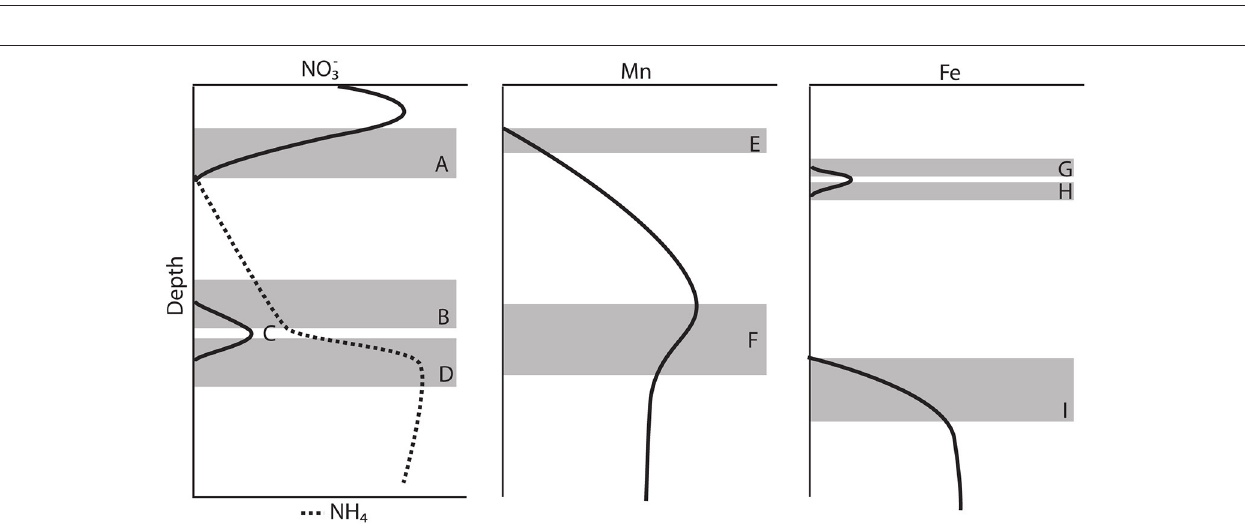
FIGURE 4 | Schematic model of the major features observed in most of the gravity core pore water profiles. (A) Consumption zone of the primary NO − 3 peak. (B) Upper zone of the secondary NO − 3 peak. (C) Secondary NO − 3 peak, change in NH + 4 gradient. (D) Lower zone of the secondary NO − 3 peak. (E) Mn + 2 appearance depth. (F) Change in the concentration gradient of Mn + 2 (G) Upper zone of the primary Fe + 2 peak. (H) Lower zone of the primary Fe + 2 peak. (I) Appearance of the secondary Fe + 2 production zone.